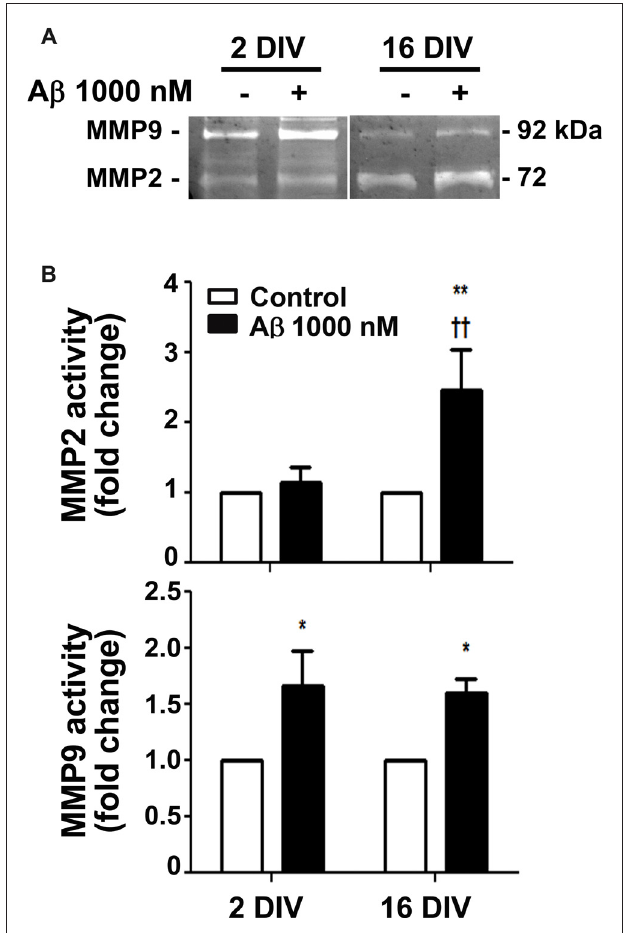
FIGURE 2 | Release of matrix metalloproteinase 2 (MMP2) and MMP9 is differently induced by amyloid- β (A β ) peptide in reactive and aged cultured microglia. Microglia that were kept in culture for 2 and 16 days in vitro (DIV) were treated with 1000 nM A β for 24 h. Activities of MMP2 and MMP9 were evaluated by gelatin zymography. (A) Representative images of zymography gels. (B) Results are expressed in graph bars as mean ± SEM. Cultures, n = 4 per group. Two-way ANOVA ( Post hoc Bonferroni test): ∗ p < 0.05 and ∗∗ p < 0.01 vs. respective non-treated Control; †† p < 0.01 vs. 2 DIV; (B) DIV × A β interaction F ( 4.39 ) , p <